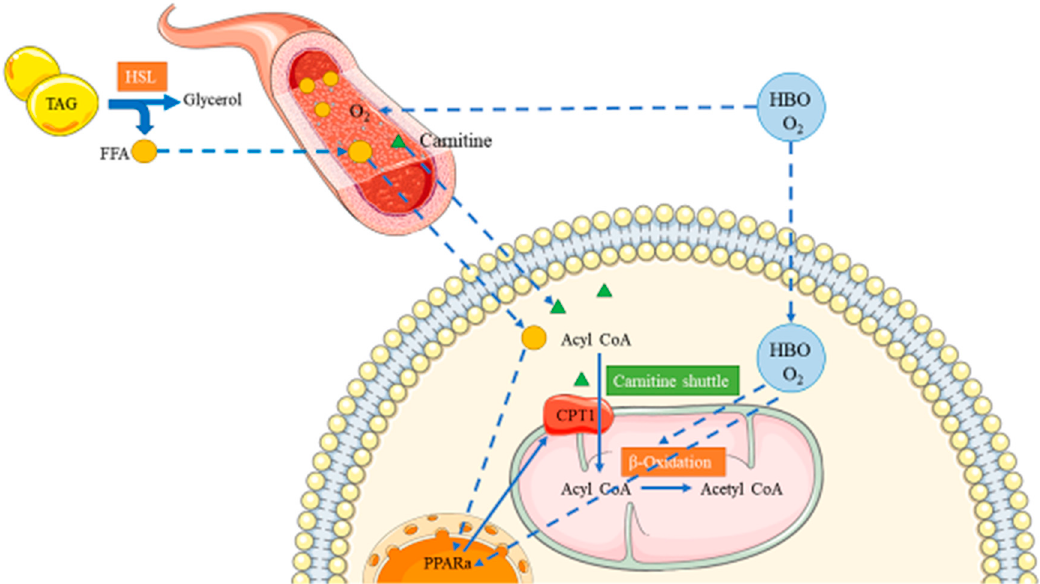
Figure 10. Proposed mode of action. TAG: triacylglycerol. HSL: hormone sensitive lipase. FFA: free fatty acid. HBO: hyperbaric oxygen. CPT1: carnitine palmitoyltransferase 1. PPAR α : peroxisome proliferator-activated receptor alpha.